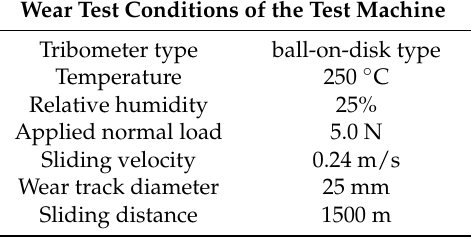
Table 1. Wear test